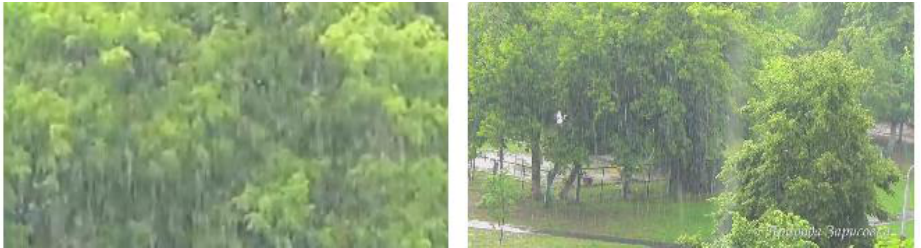
Fig. 1. Sample images with different longitudinal dimensions of rain